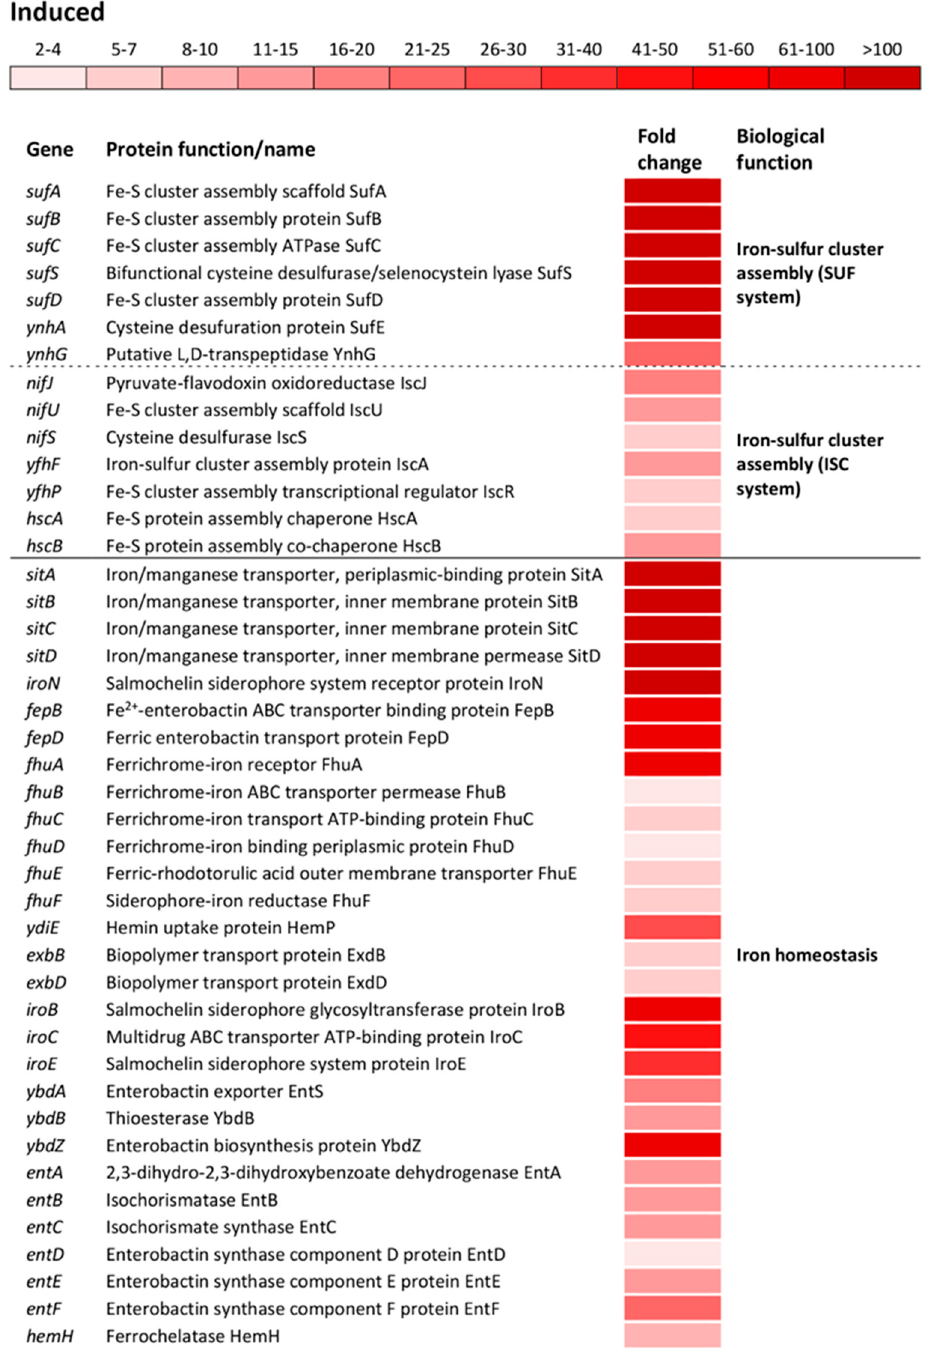
Figure 3. Di ff erential expression of genes involved in iron-cluster assembly and iron ion homeostasis. Transcriptional profiling of the wild type S . Enteritidis ATCC 13076. Isolation of RNA was carried out during the exponential growth phase. The transcriptomic profiles were determined using a HiSeq 4000 PE100 Illumina platform. The mean fold-increase of three biological replications in each gene expression after exposure to 3 mM of H 2 O 2 compared with controls (no H 2 O 2 treatment and the same growth phase) is indicated by the color scale bar. The biological functions of the induced gene were determined using the Database for Annotation, Visualization and Integrated Discovery (DAVID) as well as the National Center for Biotechnology Information (NCBI). Both sulfur utilization factor (SUF) and iron-sulfur cluster (ISC) belong to the same biological function “Iron-sulfur cluster assembly”.